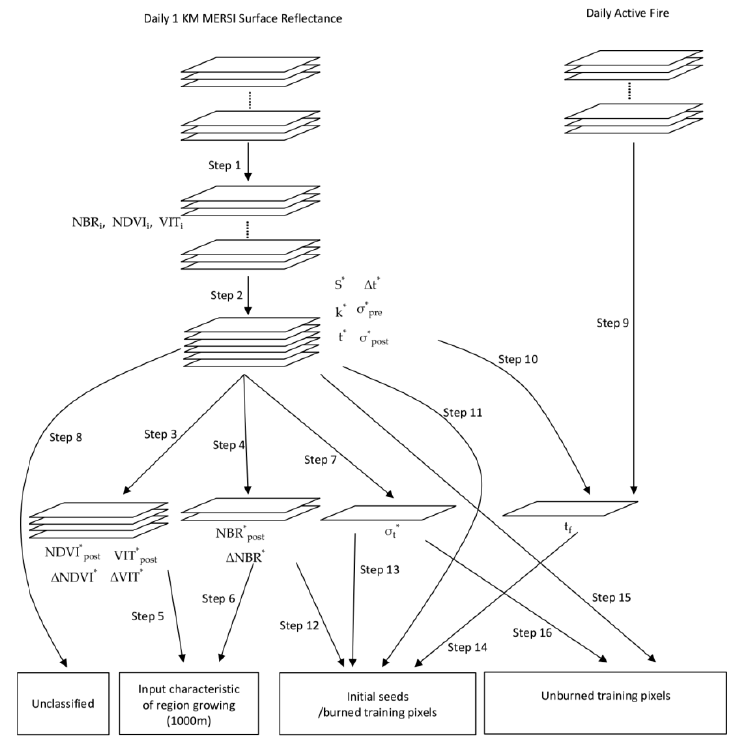
Figure 4. Flowchart for the selection of training pixels. There are a total of 16 steps. (1) Analysis of vegetation indices (VIs) time series (steps 1–6) (Section 2.3.1); (2) Temporal texture analysis (steps 6